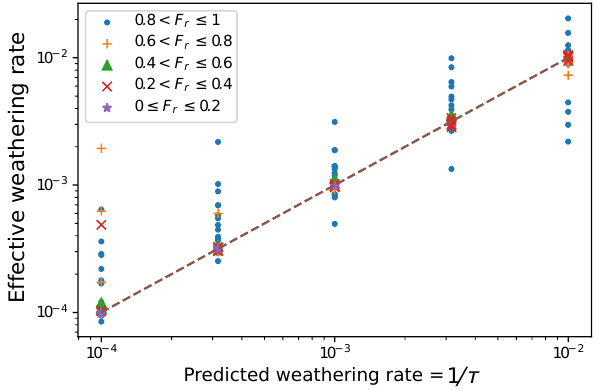
Figure 14. Regolith thickness versus time, as predicted by inverse- exponential theory (log growth; solid cyan curve) and the Grain Hill model with a range of ratios of disturbance rate ( d ) to weathering rate ( w ). Time (horizontal axis) is non-dimensionalized by multi- plying by w